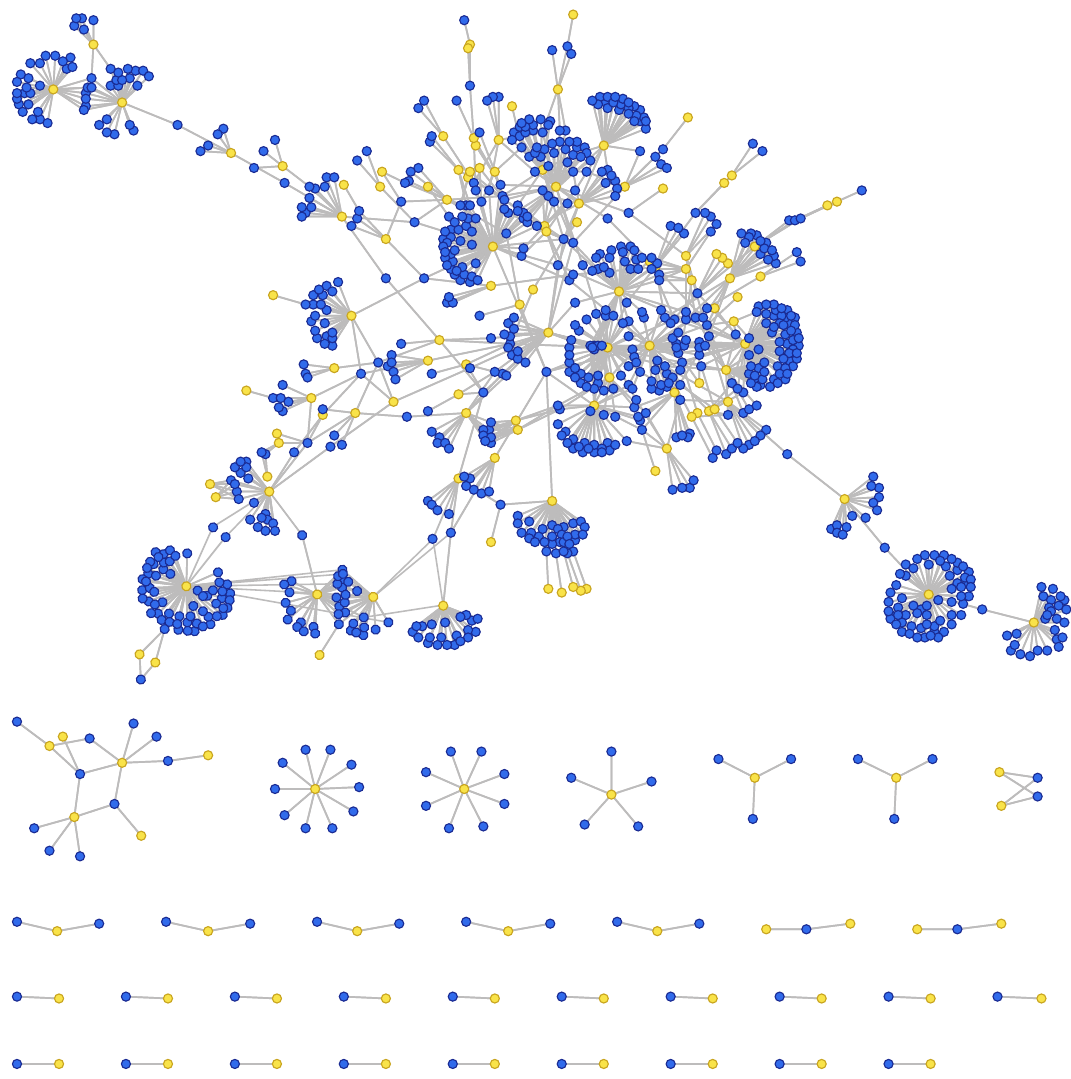
Figure 2. Photobiont-mycobiont association network. Bipartite network representation of the full dataset analysed in our study. Interactions in this network involve two different types of nodes: blue nodes correspond to mycobionts, and yellow nodes indicate photobiont species. The network consists of 34 isolated components, the largest of which has average degree � k � = 2.524 (see Table 1). Network layout was automatically generated with the FMMM algorithm (see “Materials and